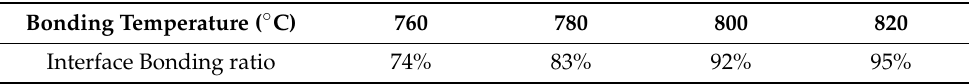
Table 2. Interface bonding ratio of the joints prepared at different bonding